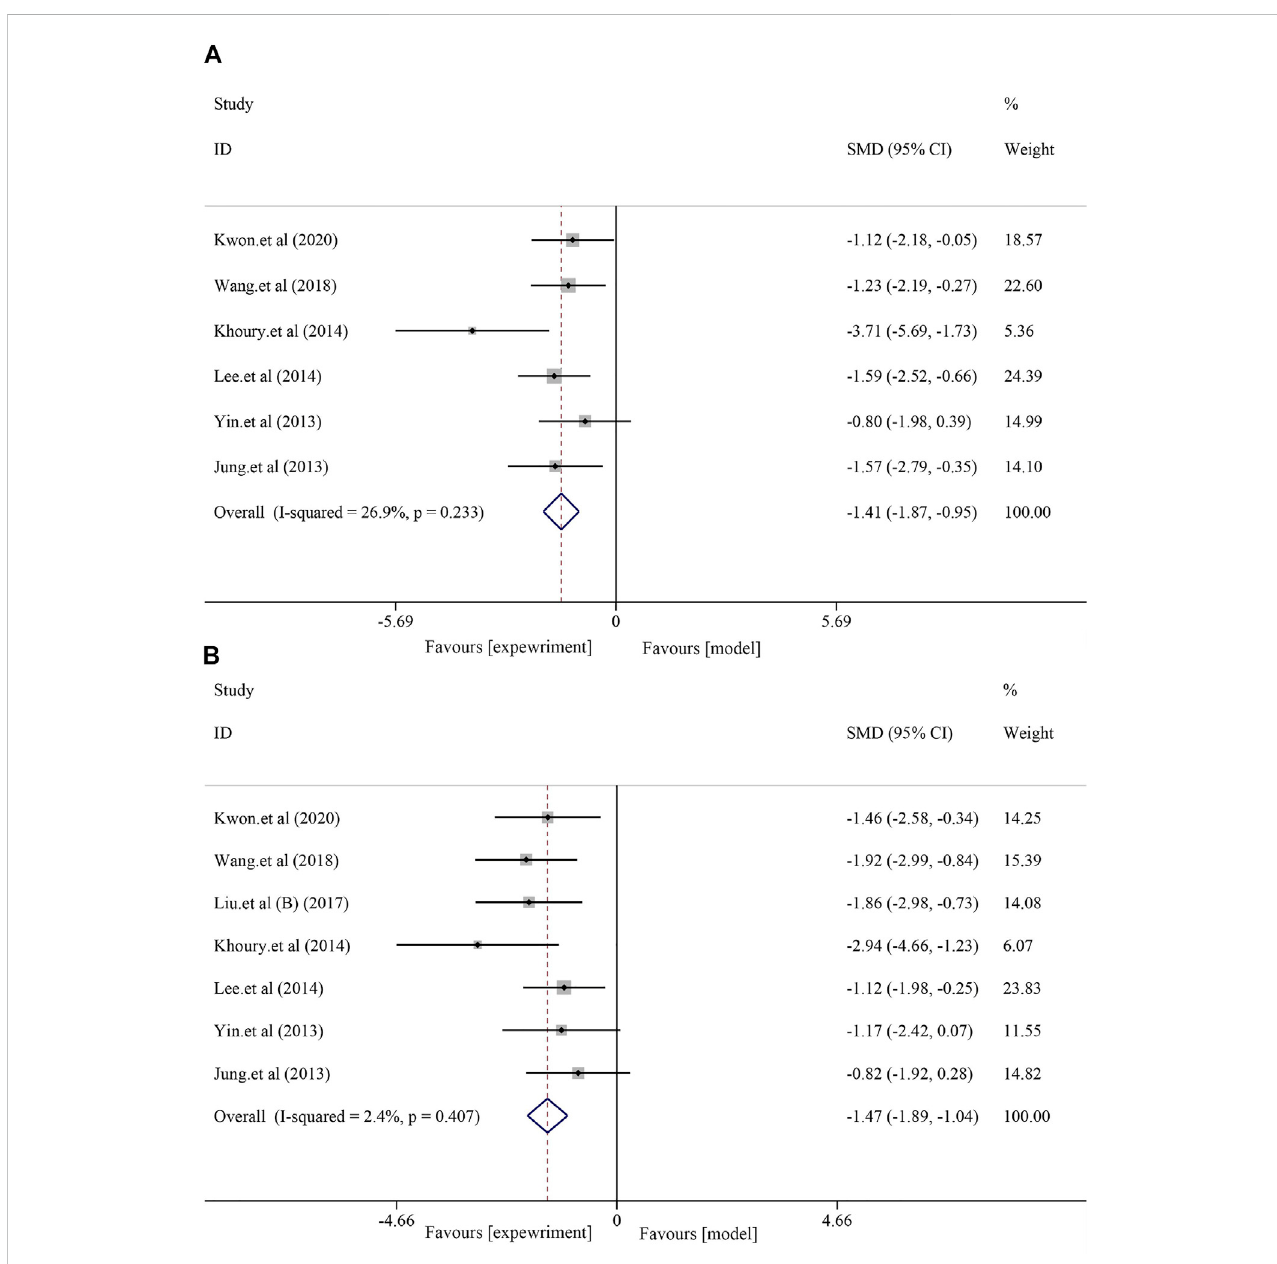
FIGURE 2 Effect of soybean on AST and ALT levels in preclinical studies. (A) Pooled effect of AST. (B) Pooled effect of